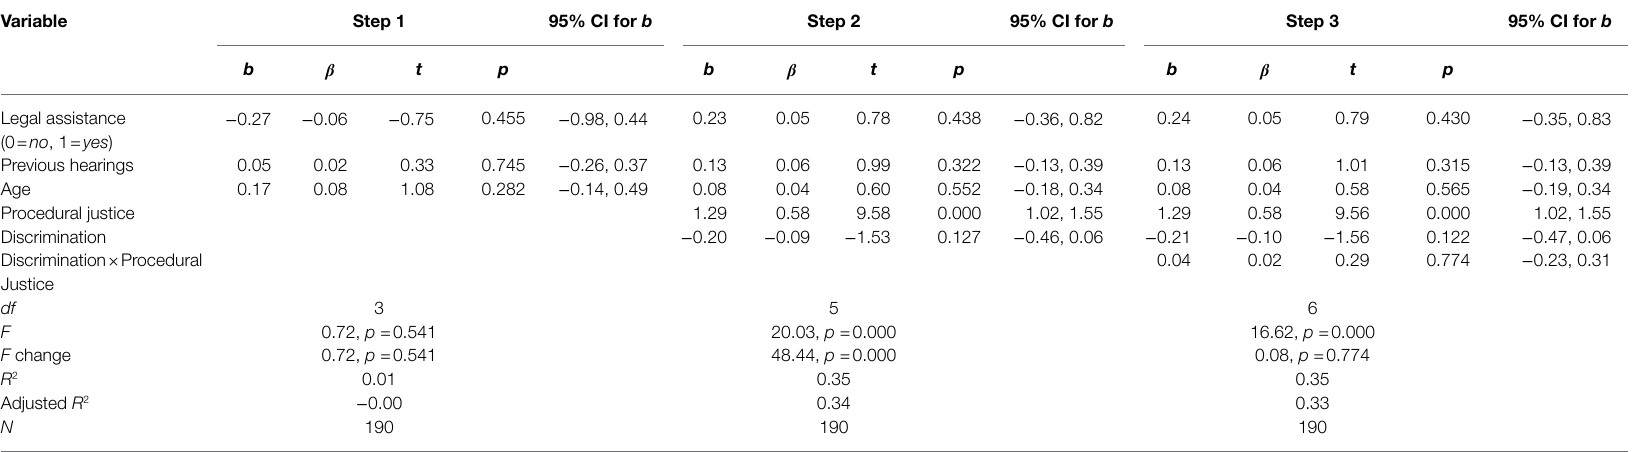
TABLE 8 | Regression results for procedural justice, discrimination, and their interaction on outcome judgments. Variable